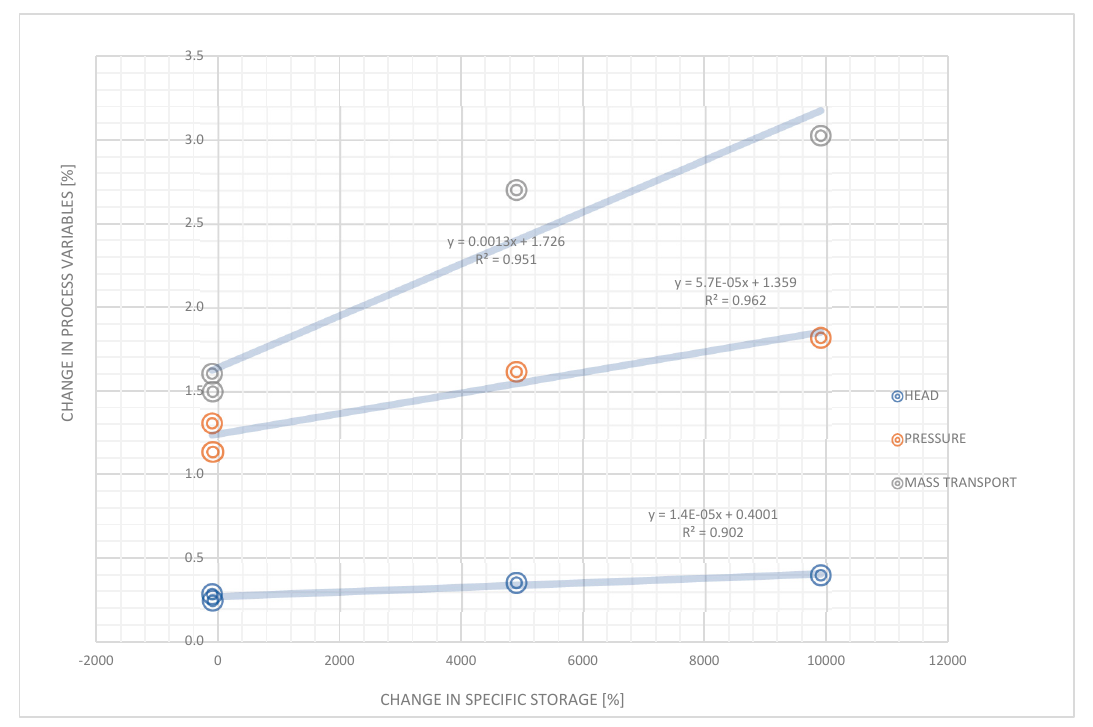
Figure 7. Impact of change in specific storage.